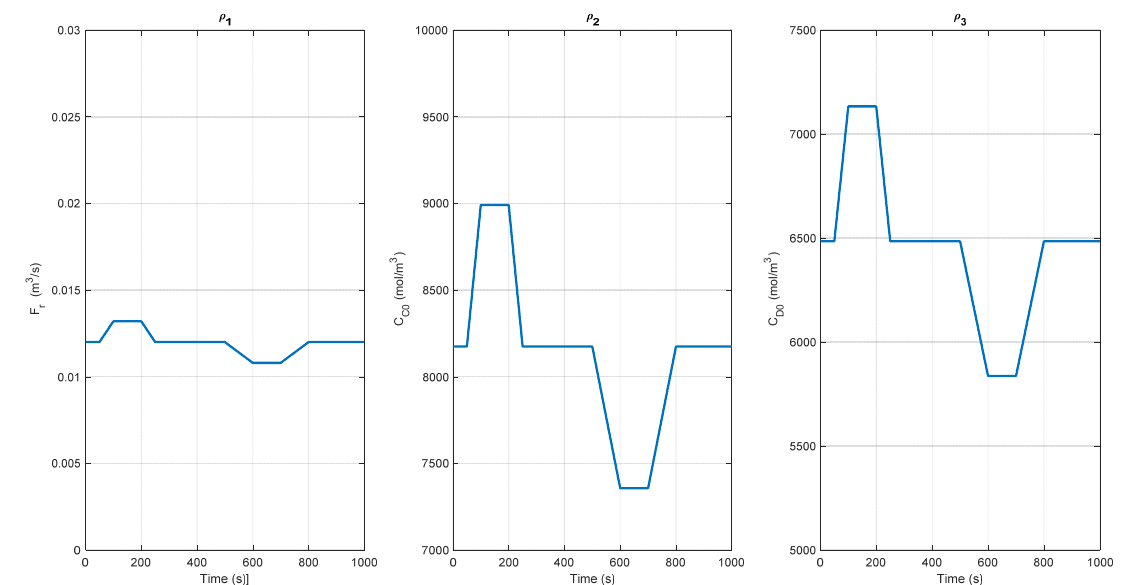
Figure 4. Scheduling variables from left to right: 𝑭 𝒓 (recycle flow rates), 𝑪 𝑪𝟎 (molar densities of pure C), and 𝑪 𝑫𝟎 (molar densities of pure D).